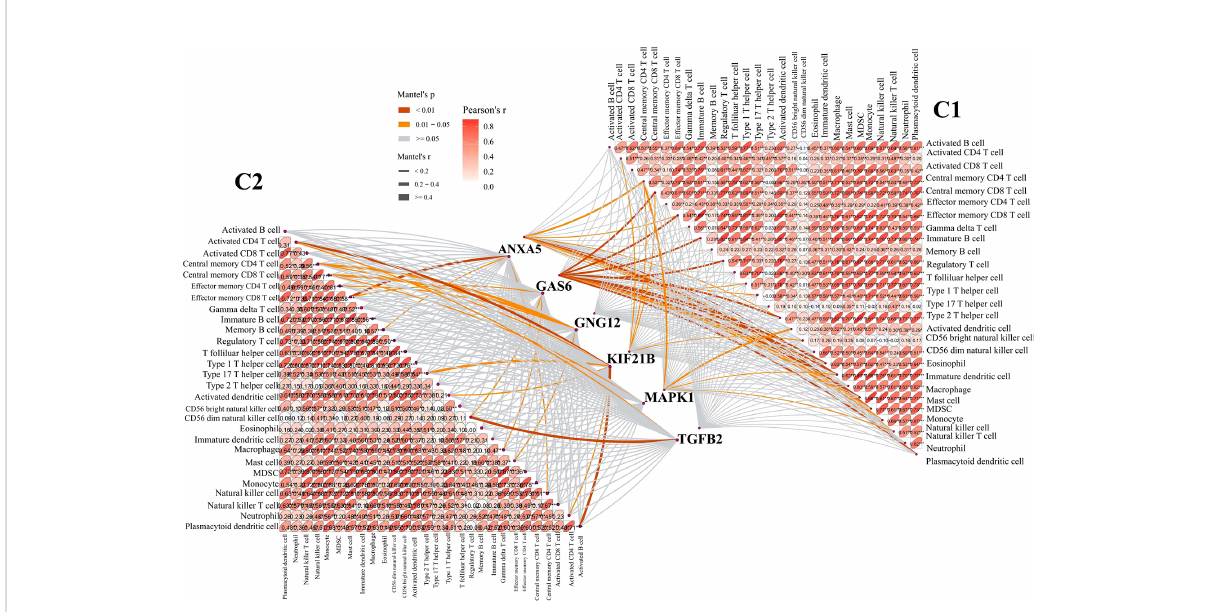
FIGURE 6 Correlation between six candidate genes and 28 immune cells. The line width represents the r value of mentel; The line color represents the p value of mentel analysis results; the numbers in the ellipse represent Pearson ’ s coef fi